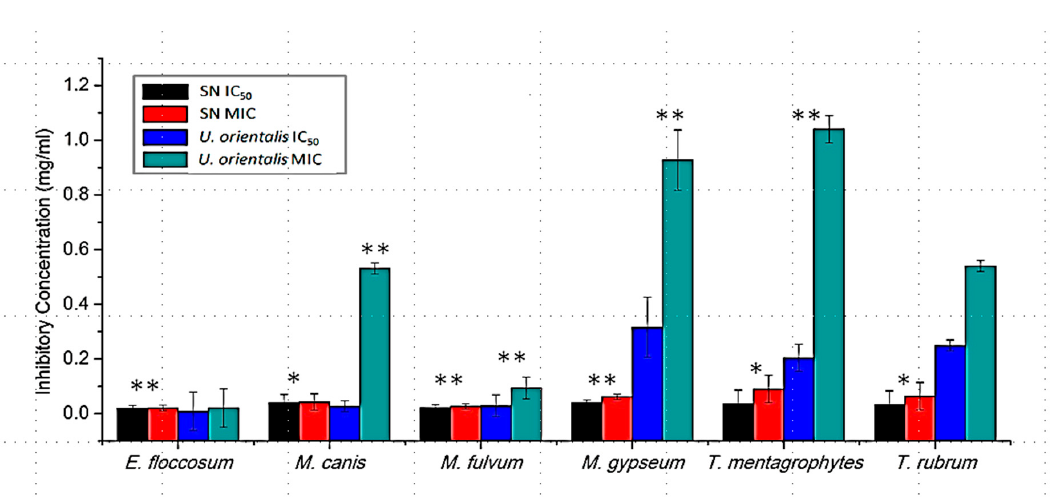
Figure 1. Antidermatophytic activity U. orientalis extract compared with Sertaconazole nitrate. Error bars show the standard error mean. ** Level of significance ≤ 0.01. * Level of significance ≤ 0.05.